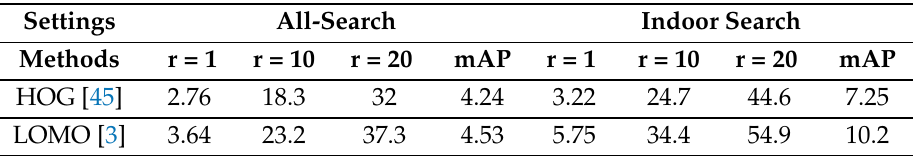
Table 1. Comparison of the results of the proposed method and other state-of-the-art methods based on the SYSU dataset. Bold numbers are the